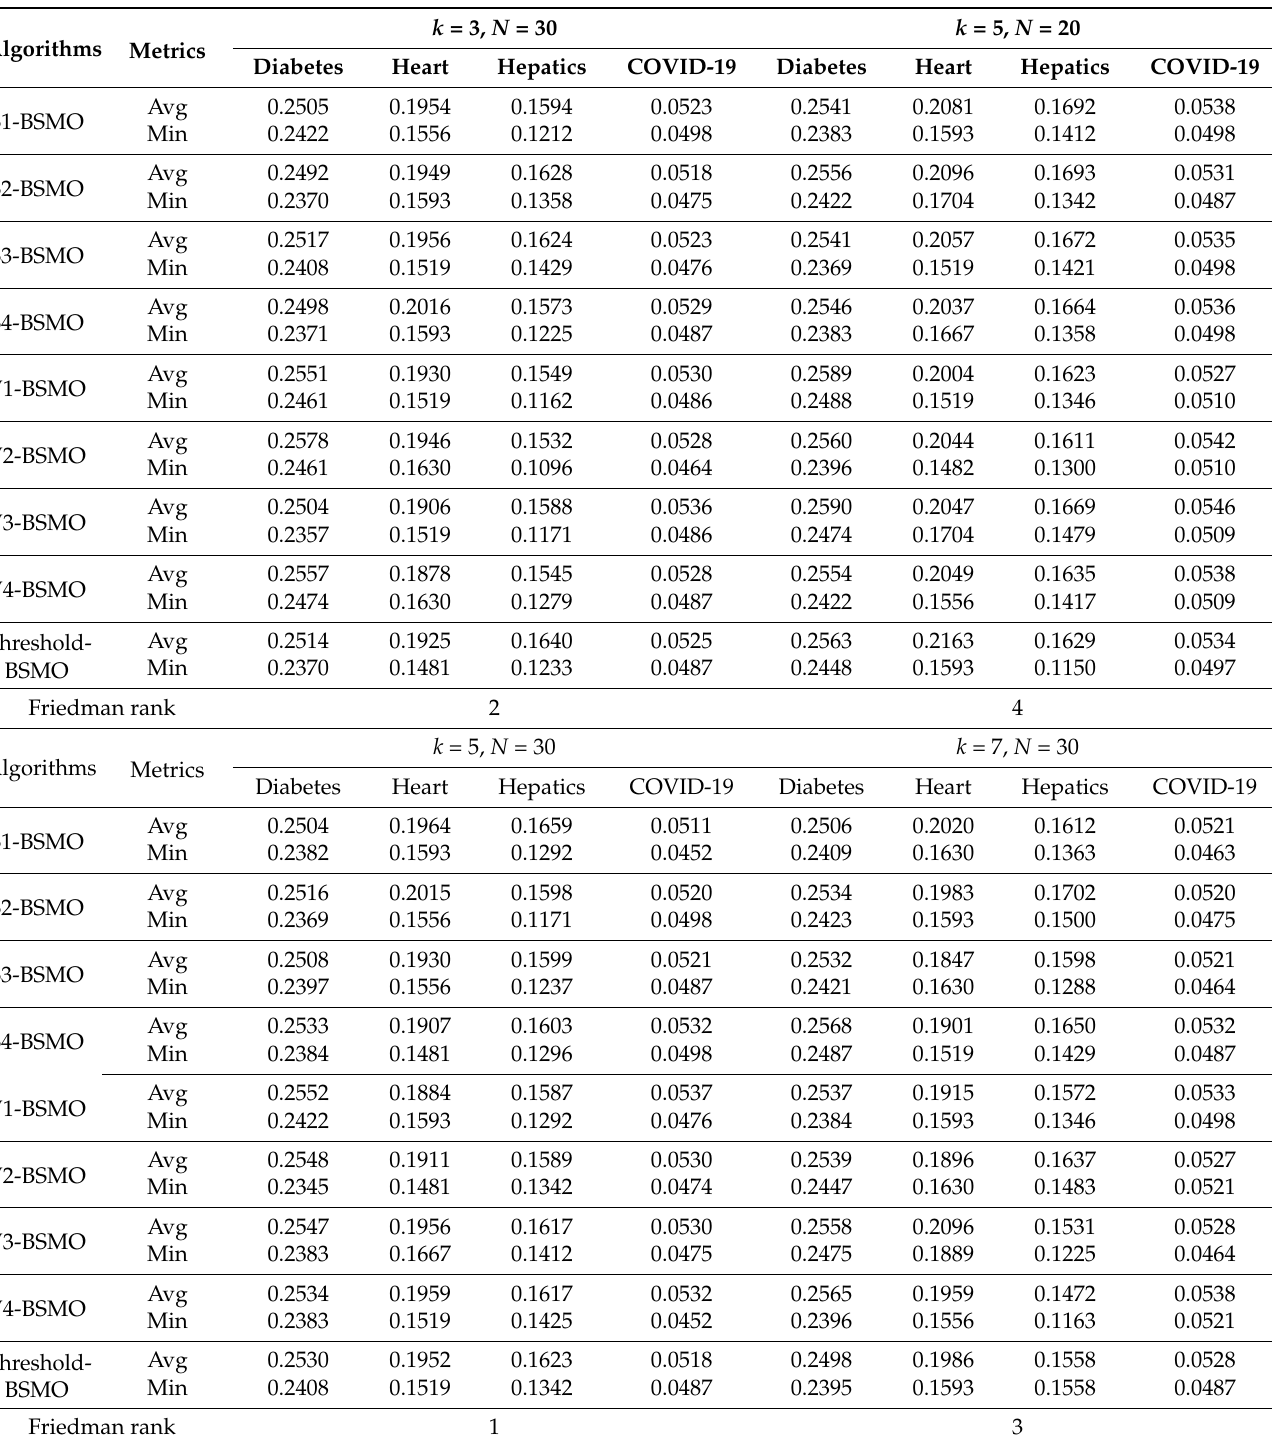
Table A2. Parameters setting of BSMO algorithm in terms of error